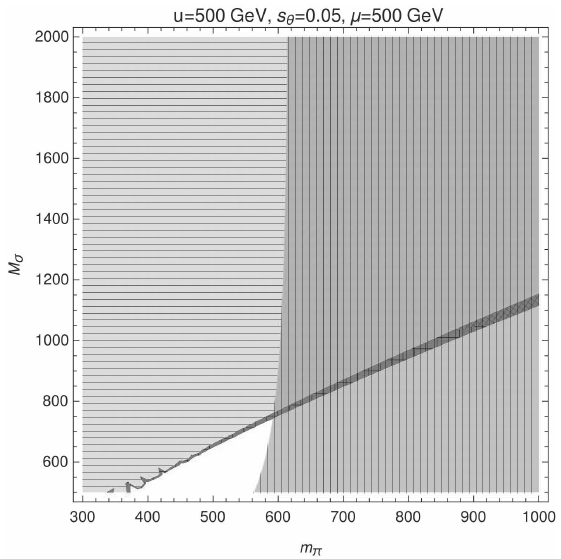
Figure 2. Analogous phase diagram in terms of M ˜ σ and m ˜ π , but for much smaller u